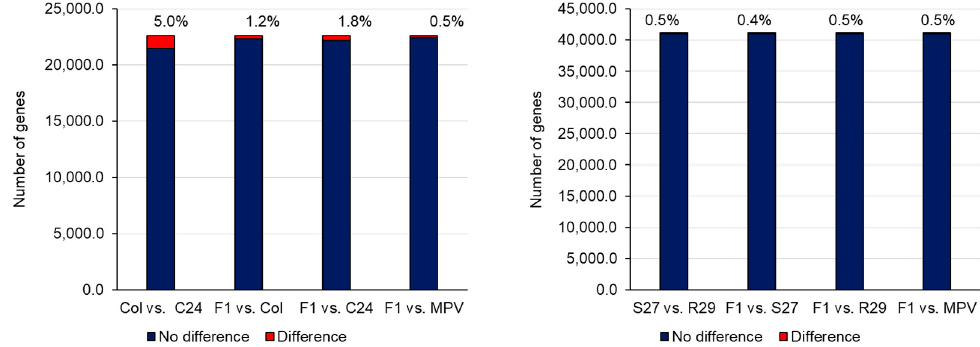
Figure 2. The number of differentially expressed genes in ten days seedlings of A. thaliana and two days cotyledon of B. rapa . The data were from [38,39].